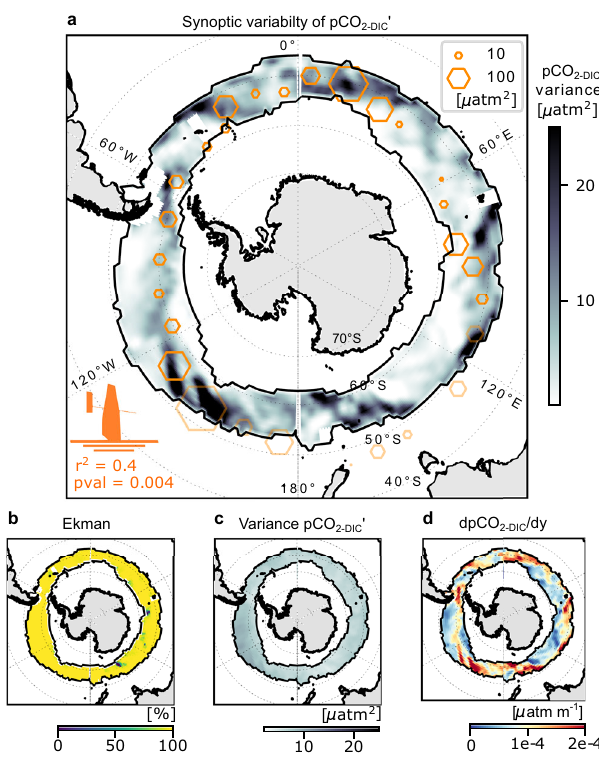
Fig. 4 The spatial distribution of synoptic variance of pCO 2-DIC in the subpolar Southern Ocean. a Modelled 7-day variance of the synoptic anomalies in the non-thermal component of pCO 2 (pCO 2-DIC ′ ) [ µ atm] 2 computed and averaged for 2019 (color bar). Overlaid are hexagons of co- located 7-day pCO 2-DIC ′ variance [ µ atm] 2 as observed from a Saildrone that circumnavigated Antarctica in 2019 28, 42 . The spatial correlation r 2 and associated p -value of estimated versus observed are indicated. Hexagons outside of the subpolar domain are displayed with transparency and are excluded from the statistics. b the relative contribution of Ekman [%] to the synoptic pCO 2-DIC ′ variability shown in a . c shows the modelled 7-day pCO 2-DIC ′ variance [ µ atm 2 ] as in a , instead computed using a spatially uniform gradient of total alkalinity (A T ) and dissolved inorganic carbon (DIC) in Eq. 3. Thus, comparing a with c shows that the spatial variability of pCO 2-DIC ′ is not driven by spatial variability in wind, but rather the spatial variability driven by spatially diverse meridional gradients of A T and DIC and thus non-thermal component of pCO 2 (pCO 2-DIC ). This is further evidenced when comparing (a) with (d) the meridional gradients of pCO 2-DIC [ µ atm m − 1 ]. Black contours on all panels show the location of the climatological sea-ice-edge maximum and the outgassing maximum for 2005 – 2019, as in Fig.